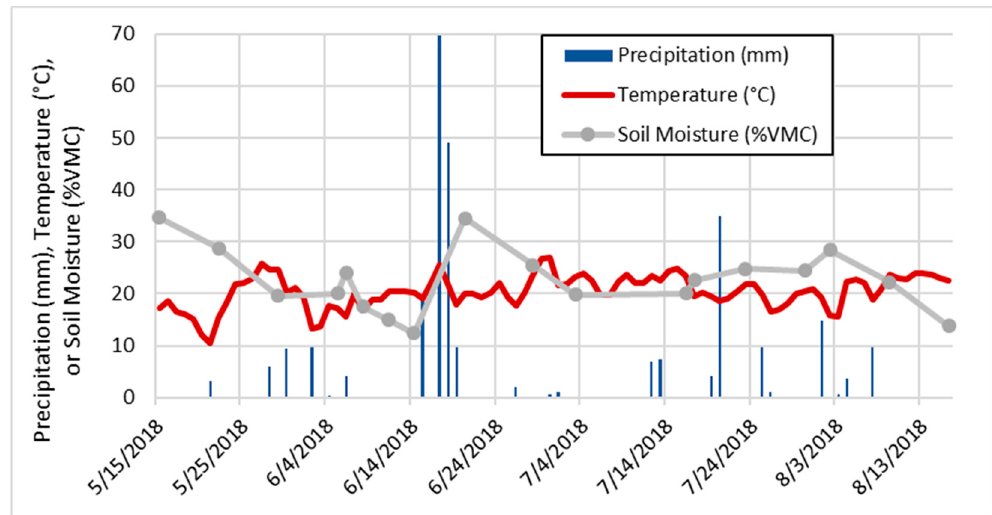
Figure 1. Daily precipitation totals (mm), air temperature (°C), and volumetric soil moisture content (%) near the study site located at the Marshfield Agricultural Research Station, Stratford, Wisconsin, USA.